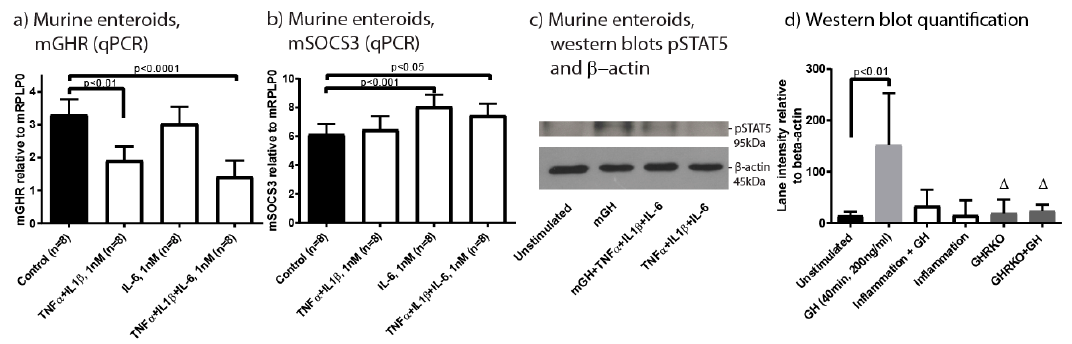
Figure 4. qPCR measuring mGHR ( a ) and mouse suppressor of cytokine signalling (mSOCS)3 ( b ) expression in murine enteroids. The cells were grown under standard conditions (black) or being stimulated with either TNF- α and IL-1 β , with IL-6 or with all three mediators, 1 nM for 8 h, n = 8; ( c ) Western blotting of phosphorylated STAT5 and β -actin in murine enteroids to evaluate the effect of mGH alone and following pre-incubation with inflammatory mediators (TNF- α , IL-1 β and IL-6) (1 nM of each in combination); ( d ) Quantification of western blots ( n = 4). Intestinal organoids from gene disrupted mice (GHRKO) were also included. Δ only two samples—therefore not included in statistics. Data presented as mean ± SD. Statistics: Kruskal-Wallis, Dunn’s correction, comparing